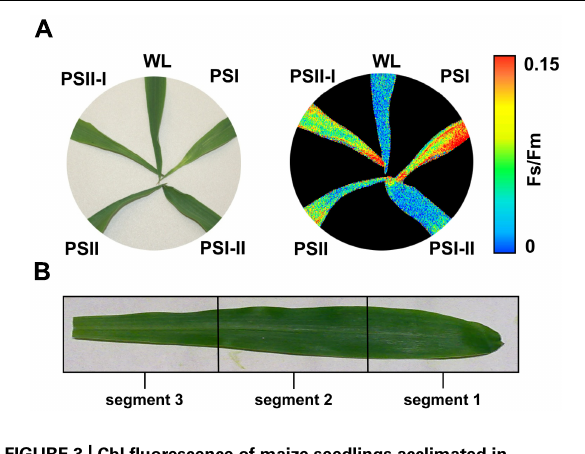
FIGURE 3 | Chl fluorescence of maize seedlings acclimated in long-term to different artificial light regimes affecting the redox state of photosynthetic electron transport. The growth light regime is indicated next to each leaf. (A) Left: appearance of leaves of differently acclimated plants under white light. Right: F s / F m values of the same leaves as detected by a CCD camera for Chl fluorescence detection given in false colors. Color bar on the right indicates the measured values. First and second true leaves were used for all analyses, the figures display representative samples. (B) Leaf sections used for more detailed analyses (compare Figures 4 and 5 ) were selected according to the field sampling.